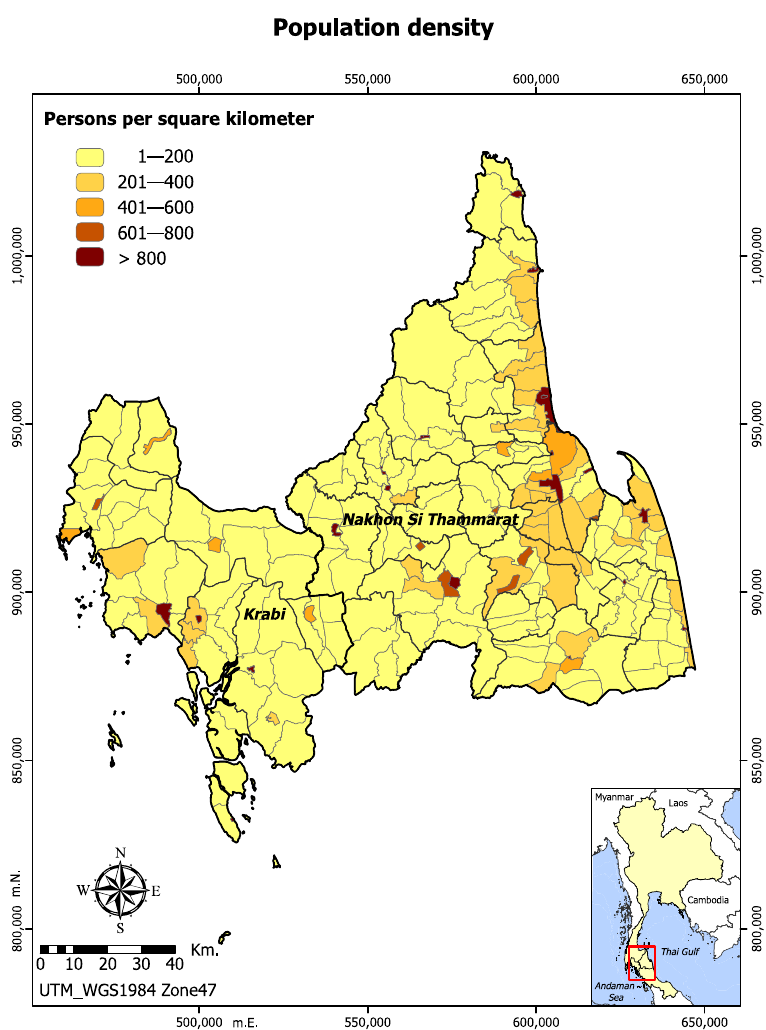
Figure 2. Population density in Krabi and Nakhon Si Thammarat, 2017.